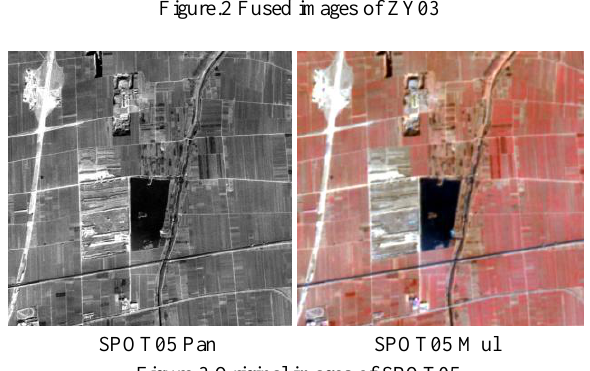
Figure.3 Original images of SPOT05